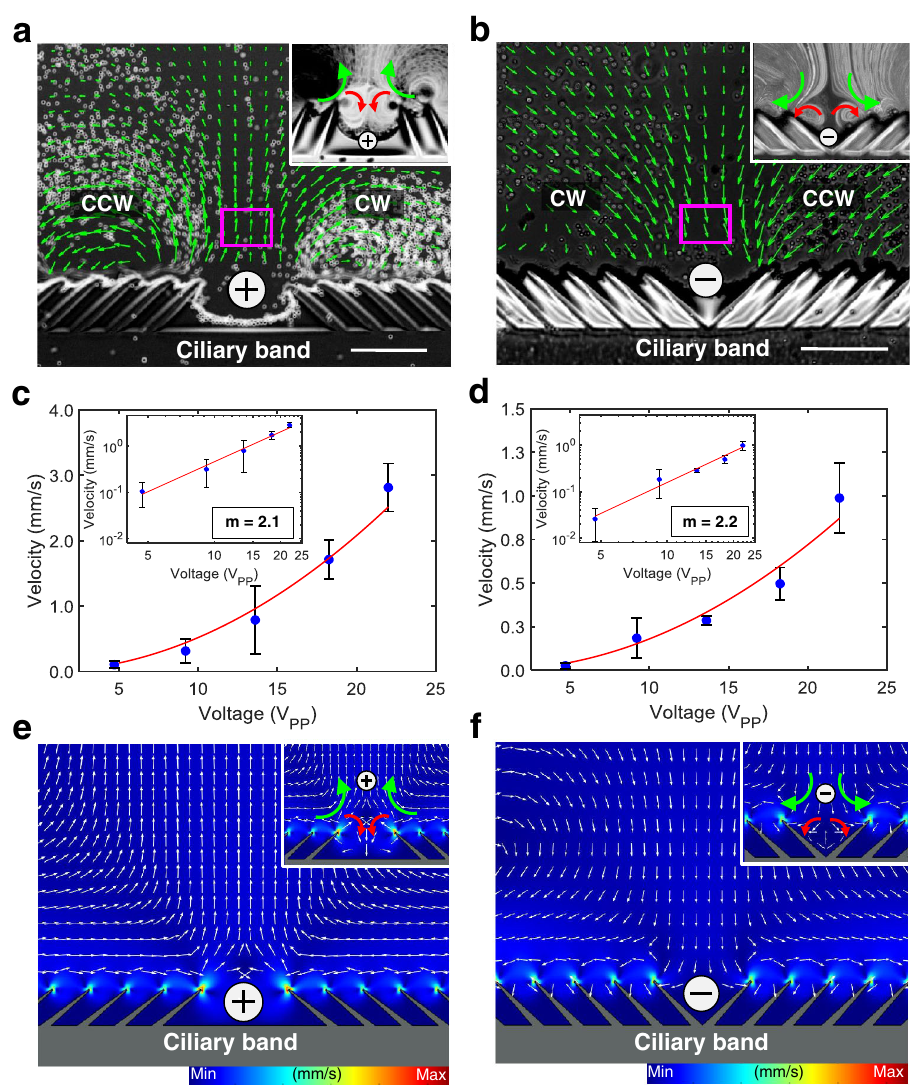
Fig. 3 Experimental, characterization, and numerical demonstration of bioinspired ultrasound ciliary bands (Supplementary Movie 4). a PIV generated velocity fi elds of a + ciliary band that causes the liquid to fl ow away on a plane perpendicular to the center of the ciliary band at excitation frequency and amplitude of 68.7 kHz and 20 V PP , respectively. The inset indicates localized counter-rotating vortices at the innermost tips of the + ciliary band con fi guration. b PIV generated velocity fi elds of a − ciliary band, which directs the liquid fl ow to the center of the band at 68.8 kHz and 22 V PP , respectively. The inset indicates localized counter-rotating vortices at the innermost tips of the − ciliary band con fi guration. Plots of average velocities of c . + and d . − ciliary bands at sites indicated by magenta boxes in a and b versus voltage applied. The particles immersed in water transport at a speed proportional to the square of the voltage applied and this quadratic relation is reasonably well satis fi ed as indicated by the log plots. In each data point, 150 − 400 velocity measurements are averaged and the standard deviation is calculated and they are represented as black error bars (Source Data 2 and Supplementary Software 2). Numerical simulation of microstreaming using perturbation approach of e + ciliary band and f − ciliary band. The insets indicate numerically calculated counter-rotating vortices at the innermost tips of the respective ciliary band con fi guration. Color bars represent normalized streaming velocities. Scale bar, 100 μ